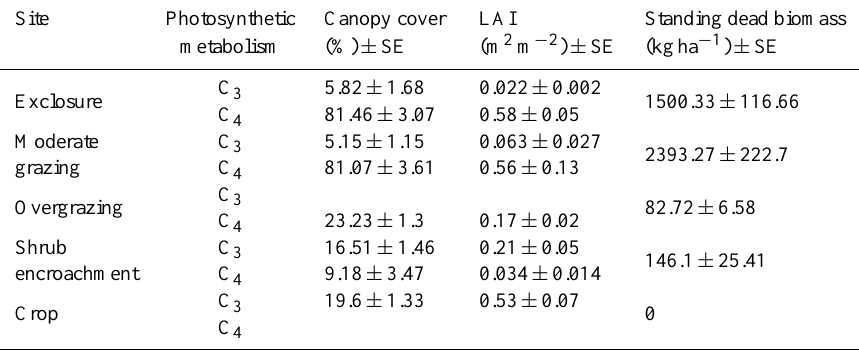
Table 2. Vegetation cover characteristics at the five experimental sites, classified according to photosynthetic metabolism of dominant func- tional